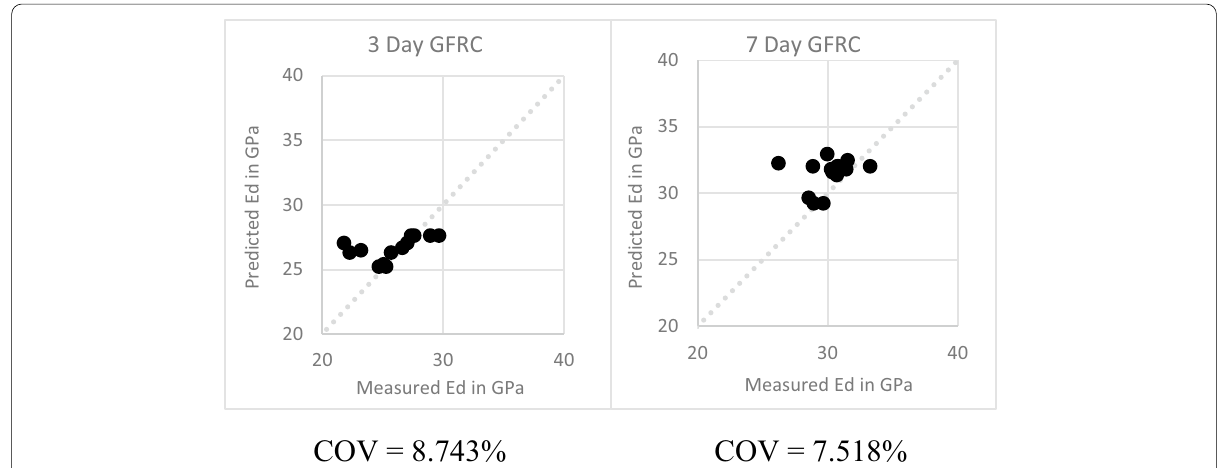
Fig. 10 Correlation between observed Ed and projected Ed for GFRC at early